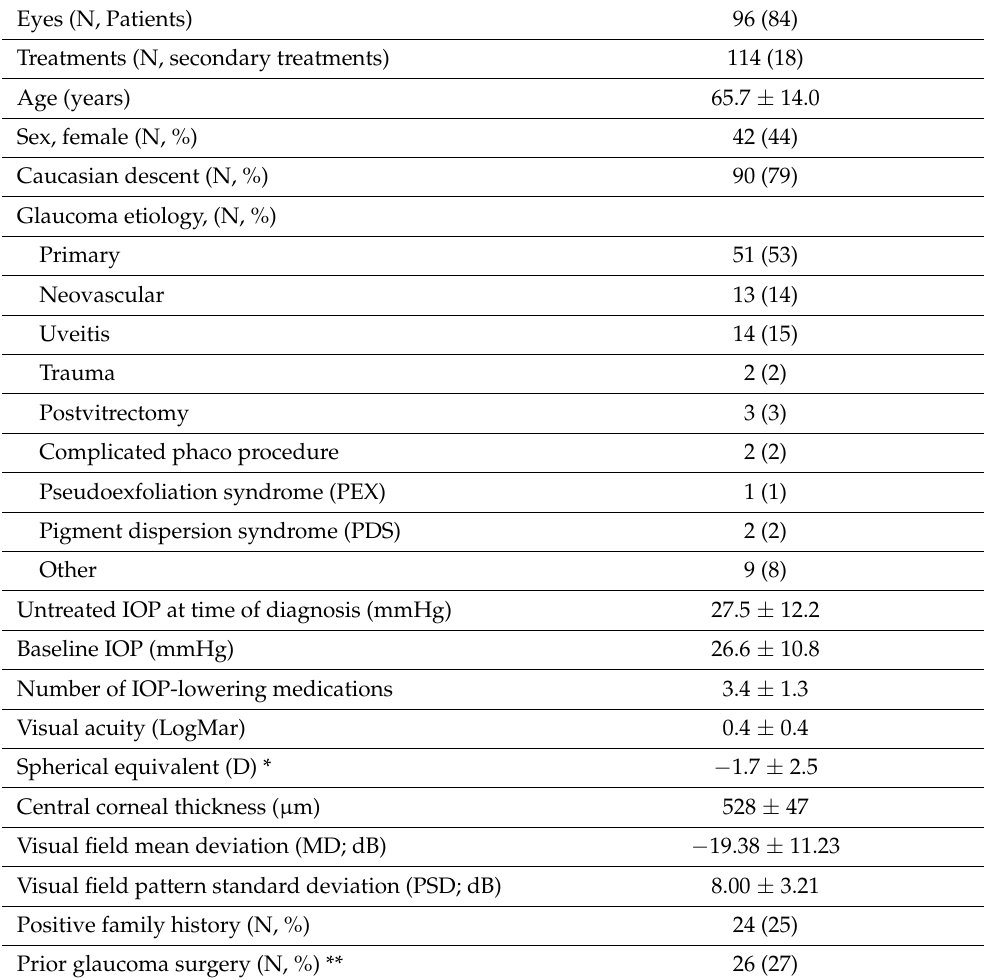
Table 1. Baseline preoperative characteristics, presented as mean ± standard deviation unless stated